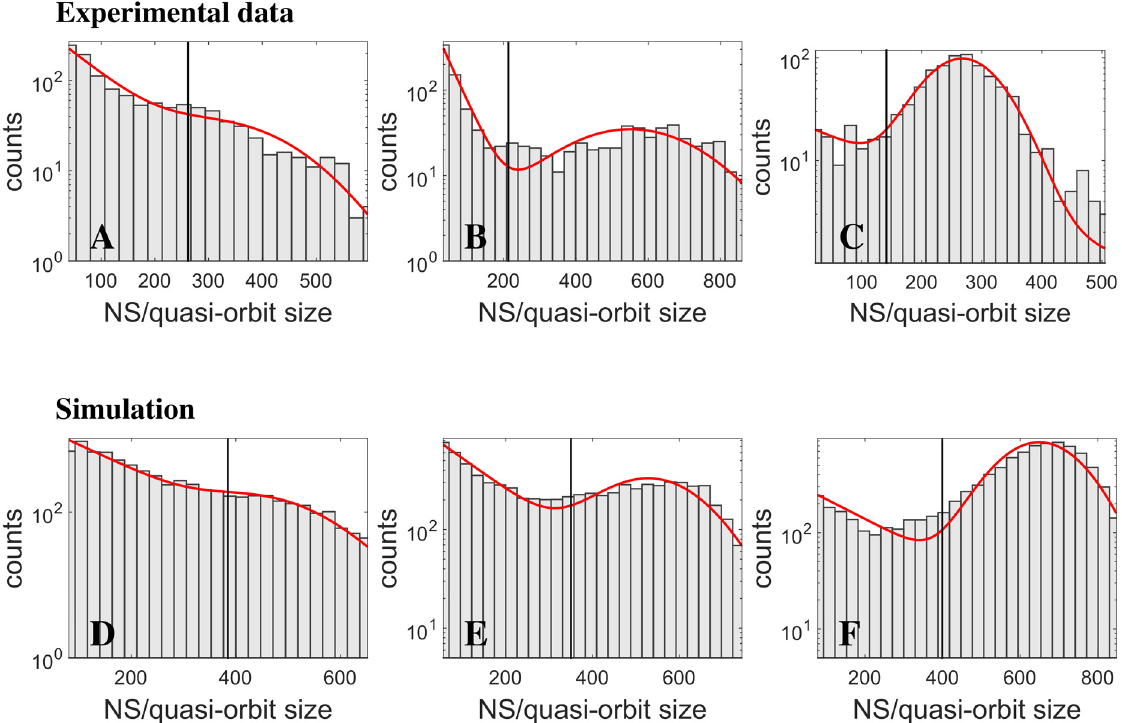
Fig 5. A broad spectrum of synchronous network events: simulations vs ex-vivo data. Panels A-C: experimental distributions of network events. Panels A and B: * 40-minute recordings from a very long recording, for the same network; panel C: * 1-hour recording from another cultured network. Panels D-F: distributions from simulations of networks corresponding to the points in Fig 2 ((w exc , w inh ) = (0.82, 0.7), (w exc , w inh ) = (0.82, 0.55), (w exc , w inh ) = (0.88, 0.55)). The three networks of panels D-F have increasing levels of subcritical excitability. Note the logarithmic scale on the y-axis. The solid lines are fits of the theoretical distribution of event sizes, a sum of an exponential (for quasi-orbits) and a Gaussian (for NS) distribution (see Models and Analysis, Eq 18). The vertical lines mark the probabilistic threshold separating NS and quasi-orbits.